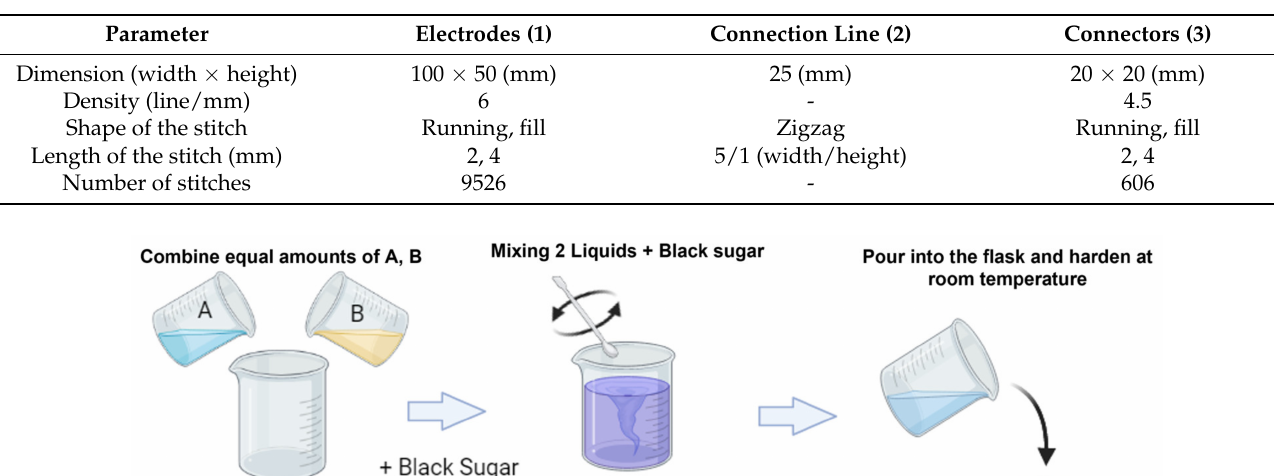
Figure 7. Preprogrammed selected shapes of the electrode, connection line, and connector. (1) embroidery connection lines, (2) embroidery electrode and (3) embroidery connector. Table 2. Specifications of the respiratory sensor.